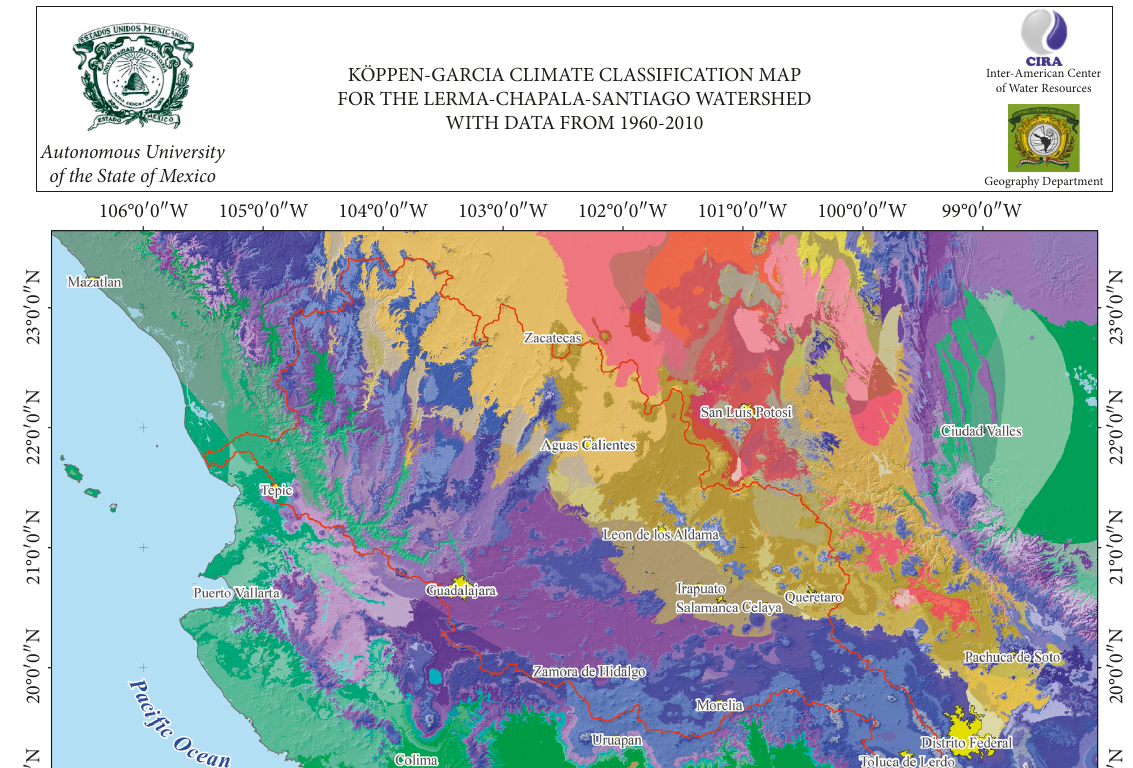
Coordinate system: GeographicDatum: WGS84Ellipsoid: WGS84Source of information: CONAGUA, INEGI y CIRAManufacturing date: March 2015Period of climate data: 1960-2010